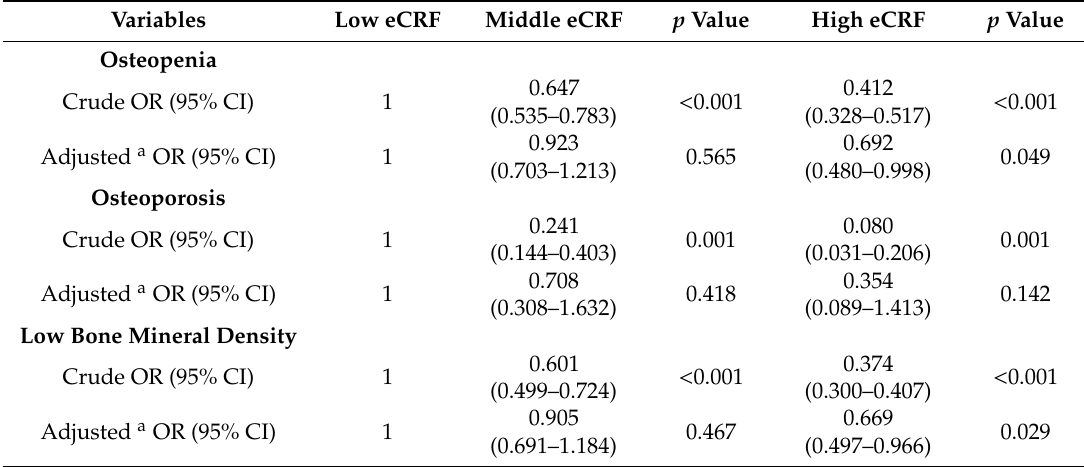
Table 3. Odds ratios (OR) and 95% confidence intervals (CI) for osteopenia, osteoporosis, and low bone mineral density by eCRF